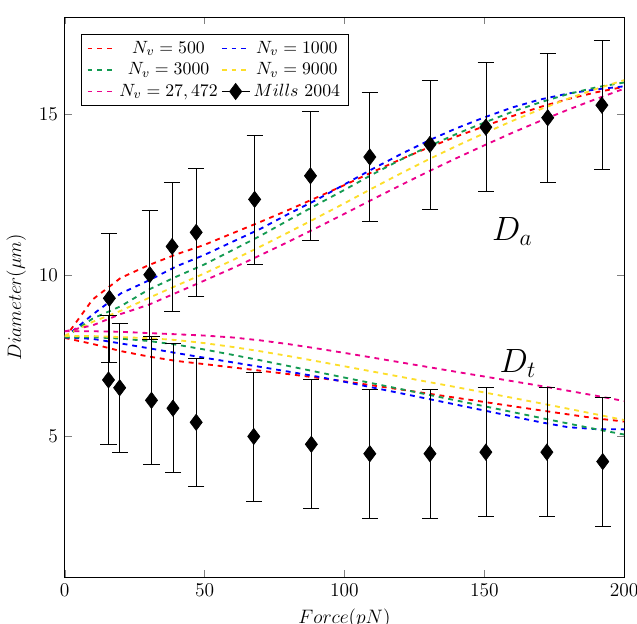
Figure 4. The evolution of the axial and transverse diameters ( D a and D t ) of the RBC versus stretching force F . The experimental data from [14] is shown with a black line with error bounds. The coarse- graining simulations are shown with lines: Red ( N v = 500), blue ( N v = 1000), green ( N v = 3000), yellow ( N v = 9000), and magenta ( N v = 27,472). Table 1. Dissipative Particle Dynamics (DPD) parameters for the model of RBC membrane for different number vertices N v . D M is the model length scale, l 0 is the equilibrium length of the links, 0 l m is the maximum length of the links, p is the persistence length, and θ 0 is the spontaneous angle. = 135 × 10 − 12 m 2 , and V tot = 94 × 10 − 18 m 3 In these cases, k a = 4900, k d = 100, k v = 5000, A tot 0 0